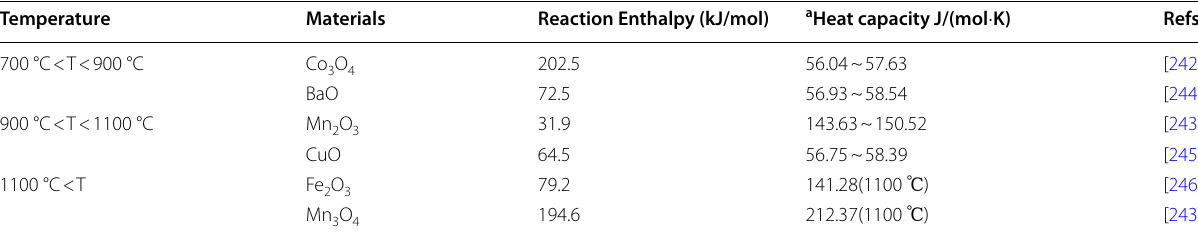
a All heat capacity data correspond to the temperature in the first column